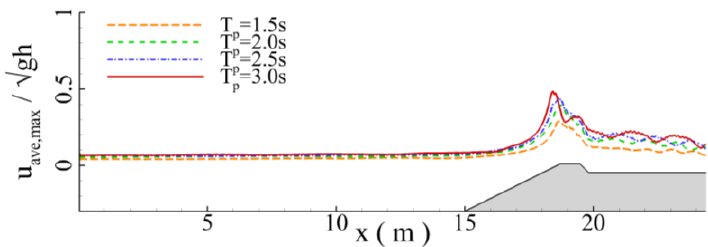
Figure 29. Space distributions of the local maximum depth-averaged velocity.